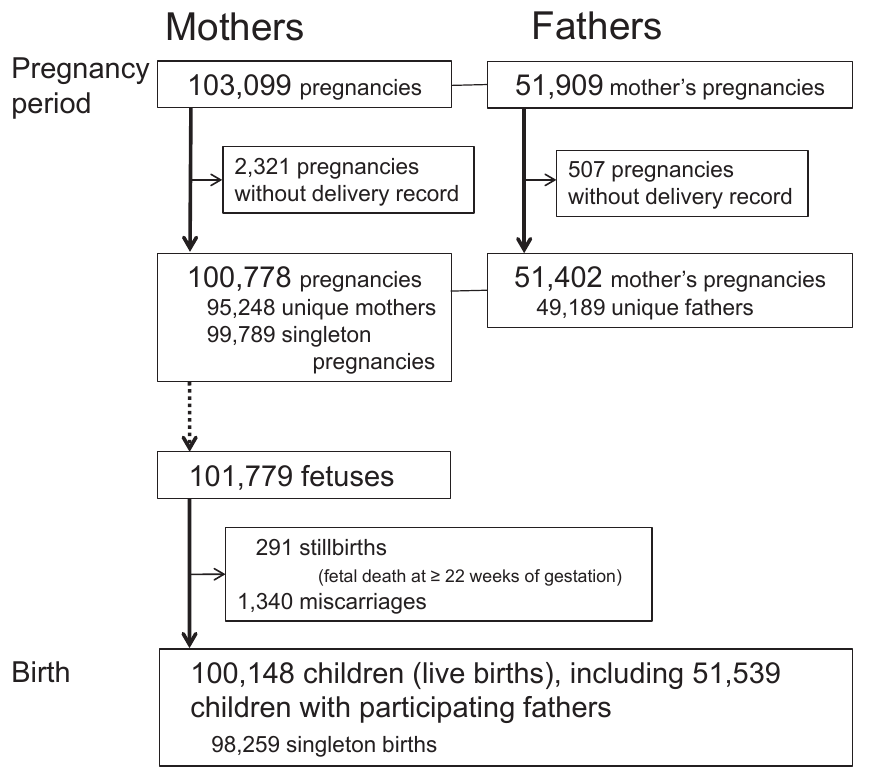
Figure 1. A Japan Environment and Children ’ s Study cohort fl ow chart from enrolment to delivery